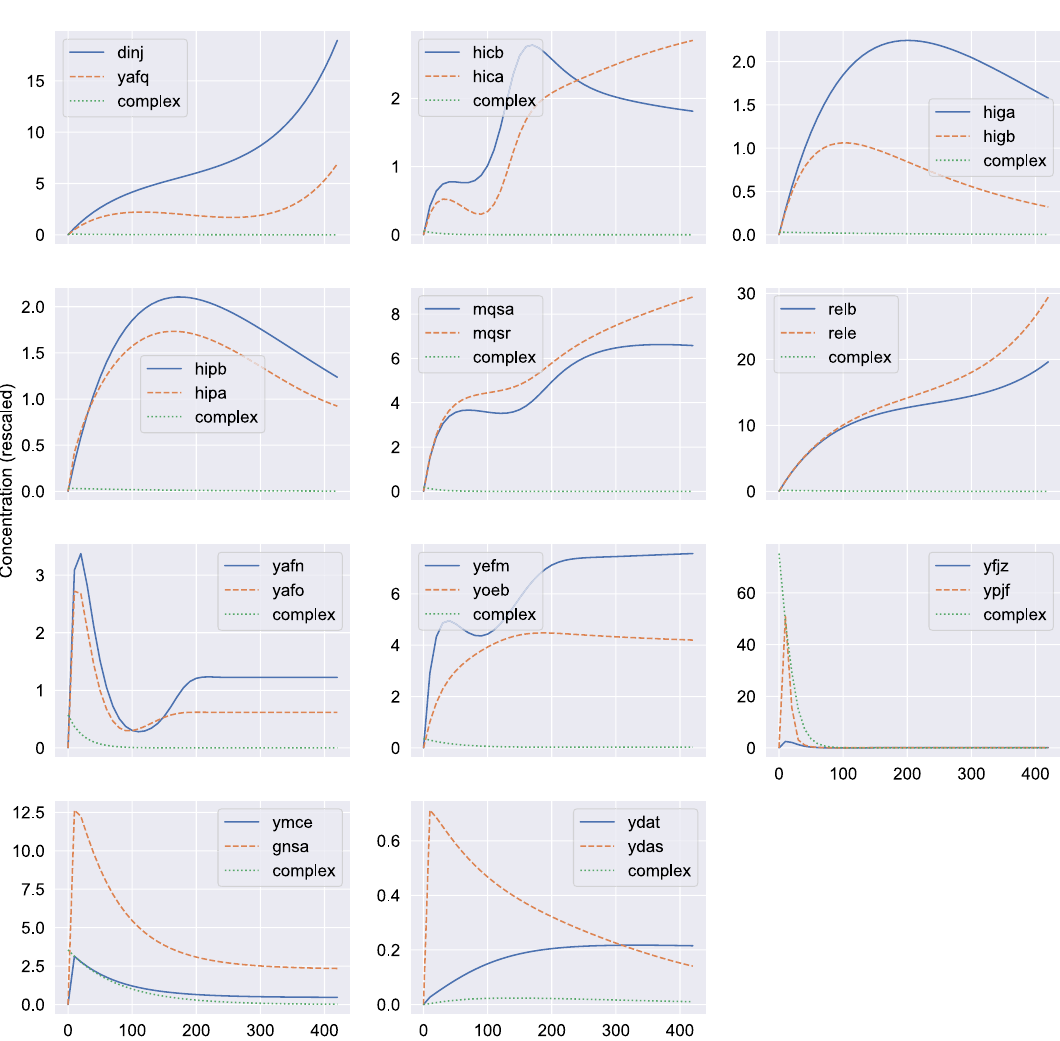
Figure 5. Toxin, antitoxin and TA complex concentrations as a function of time for 11 known TA pairs of E.coli . Solid lines show the result z 1 ( t ) of the numerical solution of the ODE system, Eqs. (4)–(6), for the antitoxin. Dashed lines show the corresponding variable z 2 ( t ) for the toxin. Dotted lines show the corresponding variable z 3 ( t ) for the TA complex. Notice that the y -axis has a logarithmic